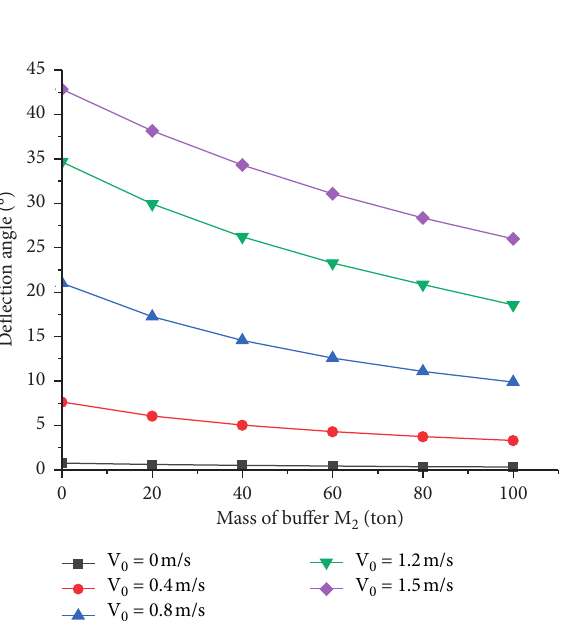
Figure 9: Effect of buffer mass on deflection angle under different sailing velocities.